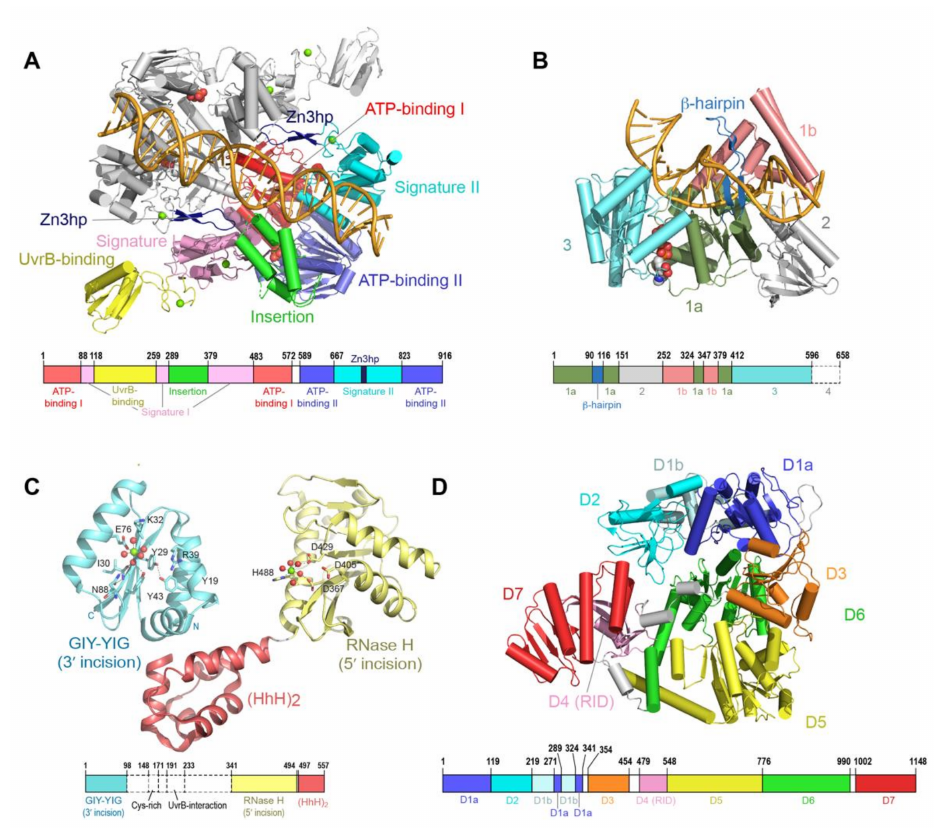
Figure 2. Architecture of nucleotide excision repair proteins. ( A ) Structure of Thermotoga maritima (Tma) UvrA dimer bound to lesion-containing duplex DNA (PDB: 3PIH) [19], with α -helices depicted as cylinders and β -strands as arrows. One protomer is colored by domains, whereas the other is shown in gray. The Zn atoms are shown in light green; the bound ADP molecules are shown as space-filling models. The dimer was generated by application of a crystallographic two-fold axis to the contents of the crystallographic asymmetric unit, which contains one molecule of UvrA and one strand of DNA. The location of each protein domain is projected onto the primary sequence of Tma UvrA, shown as a bar. ( B ) Structure of Bacillus caldotenax (Bca) UvrB tethered to duplex DNA via disulfide crosslinking (PDB: 6O8E) [47]. The protein is colored by domains; the bound ADP molecule is shown using space-filling model. The location of each protein domain is projected onto the primary sequence of Bca UvrB, shown as a bar. ( C ) Structures of Thermotoga maritima (Tma) UvrC catalytic domains and DNA-binding domain. The GIY-YIG catalytic domain for 3 (cid:48) incision (PDB: 1Y1D) [48] and the RNase H-like catalytic domain for 5 (cid:48) incision (PDB: 2NRZ) [49] are shown in cyan and yellow, respectively. Amino acid residues that have been identified as important for activity are shown as sticks; the bound divalent metal ions and the coordinating water molecules are shown as green and red spheres, respectively. The (HhH) 2 DNA binding domain is shown in light red. The location of each domain is projected onto the primary sequence of Tma UvrC, shown as a bar. Dashed regions represent parts of UvrC whose structures are not currently available. ( D ) Structure of Escherichia coli (Eco) Mfd (PDB: 2EYQ) [50]. The protein is colored by domains. The location of each protein domain is projected onto the primary sequence of Eco Mfd, shown as a